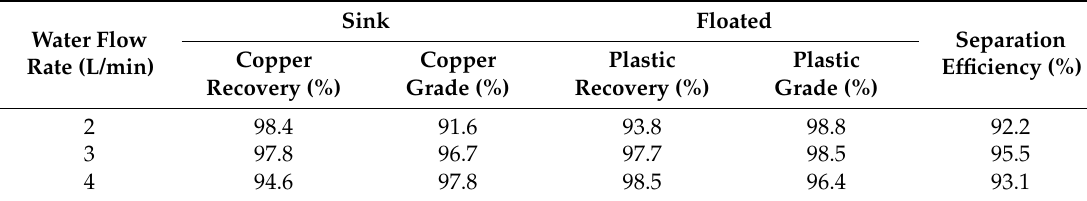
Table 3. Experimental matrix and results of jigging separation (average of three replicates). Water Flow Rate